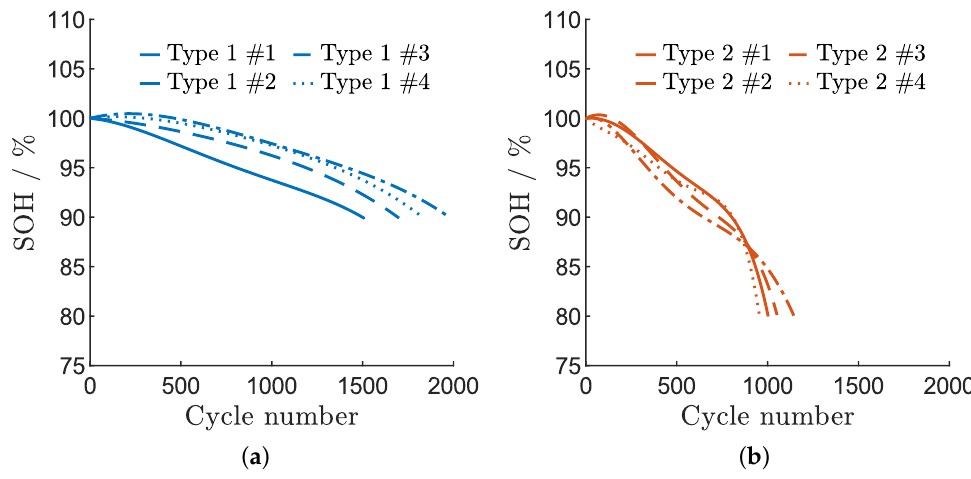
Figure 2. Degradation behaviour of the aged cells. ( a ) cell type 1 until 90% SOH; ( b ) cell type 2 until 80% SOH.